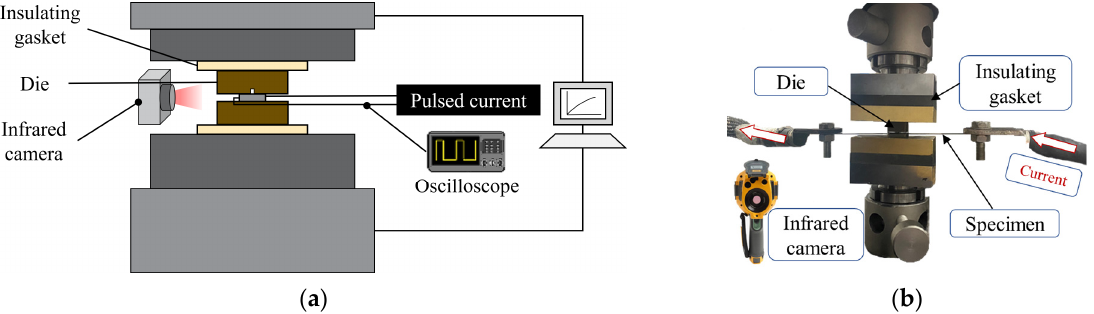
Figure 1. Electrically assisted micro ‐ filling experiment platform: ( a ) Schematic diagram; ( b ) Physical installation.